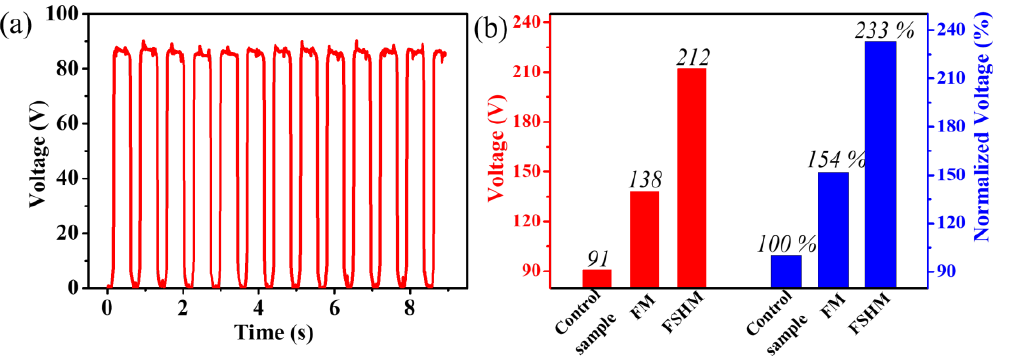
Figure 6. ( a ) V oc of flexible c-TENG, ( b ) comparison diagram of V oc of flexible TENG based on control PVDF-HFP membrane, FM and FSHM, respectively.